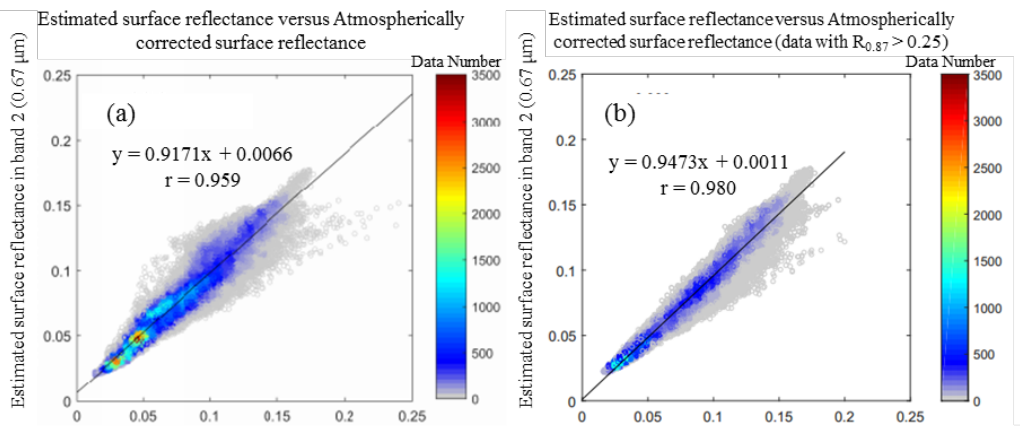
Figure 5. Comparison of estimated surface reflectances and atmospherically corrected surface reflectances at 0.67 μm: ( a ) experimental data; and ( b ) experimental data with reflectance of band 3 larger than 0.25.